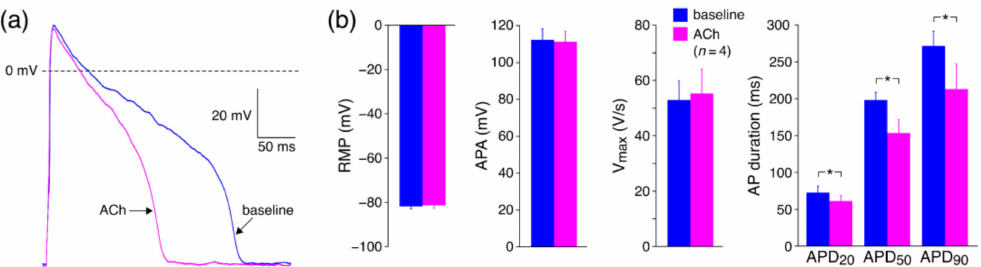
Figure 4. Effects of ACh on APs of human induced pluripotent stem cell derived cardiomyocytes (hiPSC-CMs) with limited interference of K + currents. ( a ) Typical examples of APs elicited at 1 Hz in absence (baseline) and presence of ACh. ( b ) Average AP parameters in absence and presence of ACh ( n = 4). RMP: resting membrane potential; APA: AP amplitude; V max : maximum AP upstroke velocity; APD 20 , APD 50 , and APD 90 : AP duration at 25, 50, and 90% repolarization, respectively. * p < 0.05 (paired t